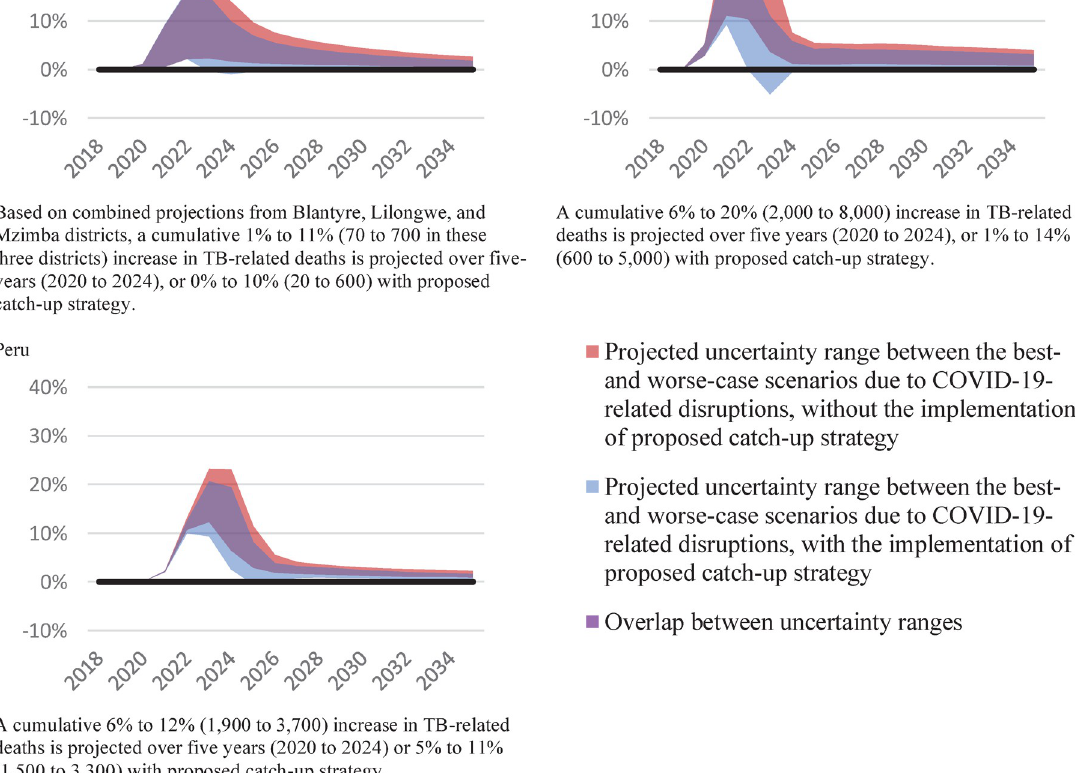
Fig 4. Impact on TB-related deaths, relative difference to the status quo counterfactual, 2018–2035.